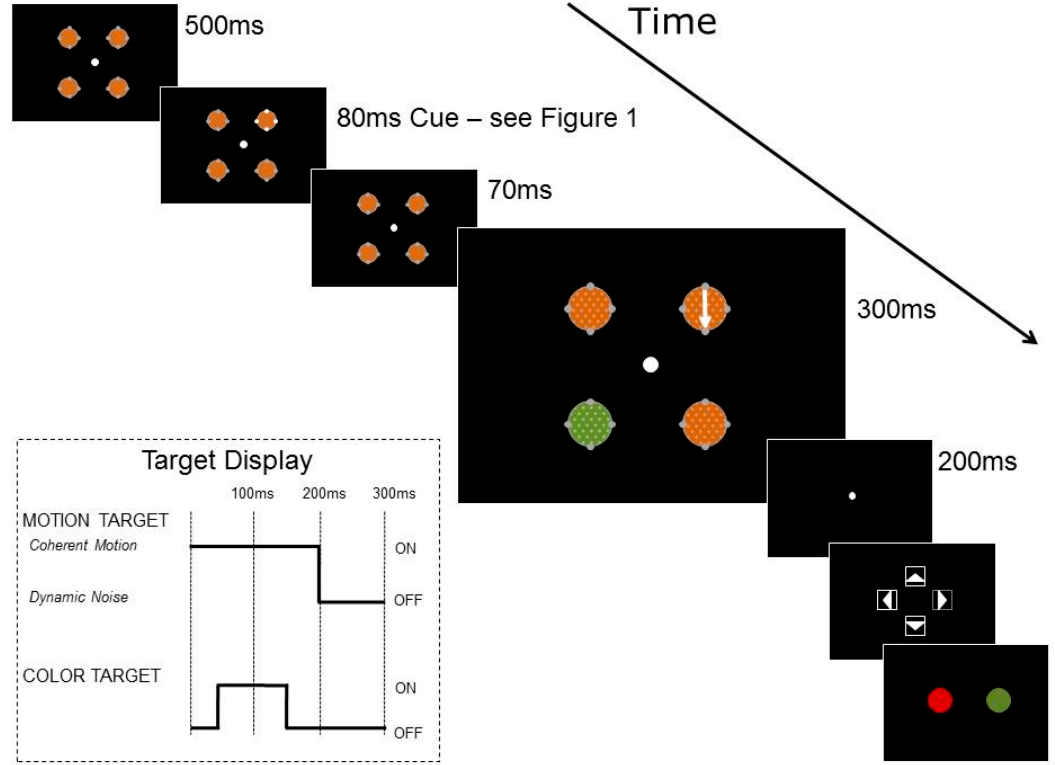
Figure 2. Trial structure for cueing experiment with motion discrimination and color discrimination, cues are shown in more detail in Figure 1. Trial shown is a luminance cue trial, in which motion appears at the cued location and color appears at an uncued